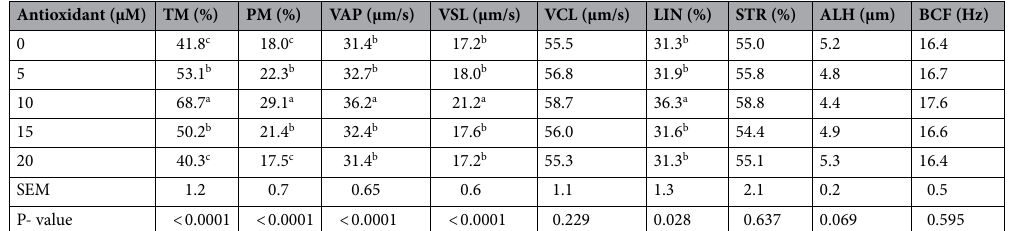
Table 1. Effect of different levels of tempol on motility parameters of rooster sperm. Different superscripts within the same column indicate differences among groups (P < 0.05). TM total motility, PM progressive motility, VSL straight–line velocity, VAP average path velocity, VCL curvilinear velocity, LIN linearity, STR straightness, ALH mean amplitude of the lateral head displacement, BCF mean of the beat cross